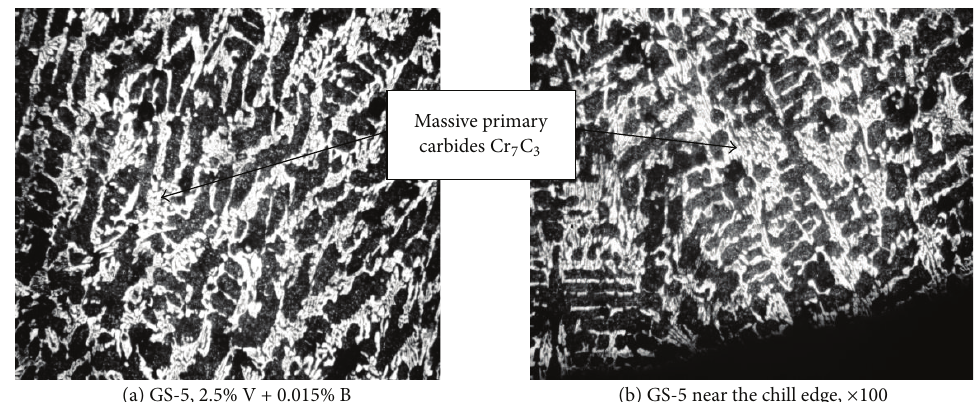
Figure 5: As-cast microstructure of GS-5 (2.5 V + 0.015 B) experimental steel.